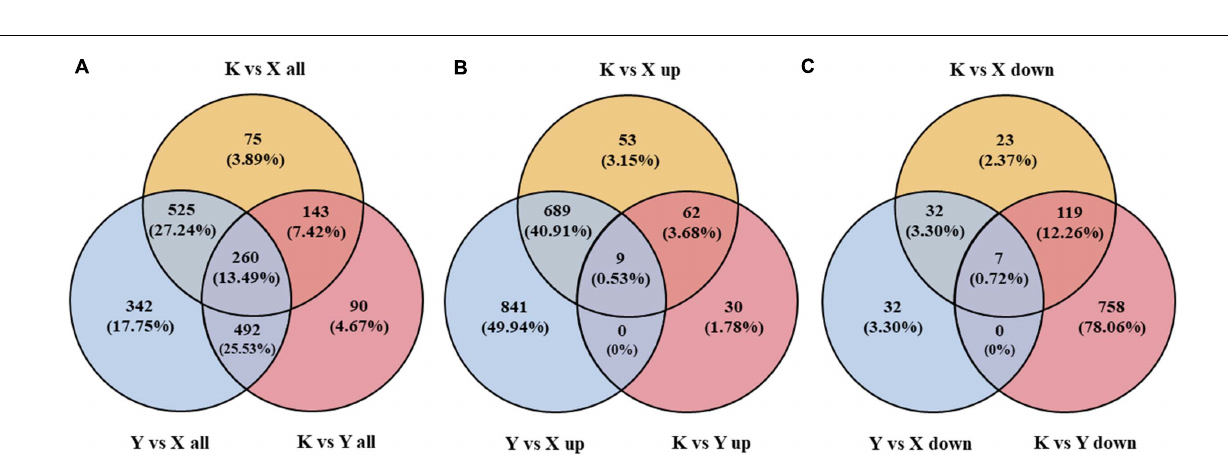
Frontiers in Plant Science |